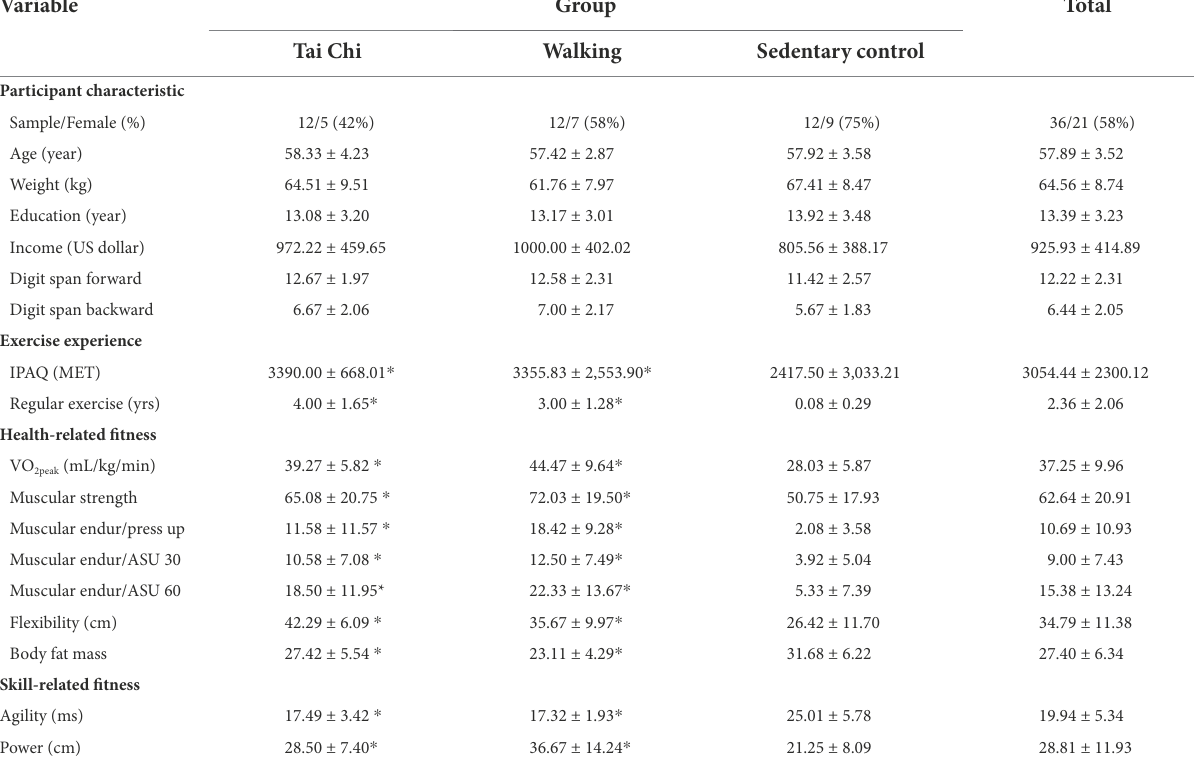
TABLE 1 Description of participants characteristic, exercise experience, and health-and skill-related fitness among three groups. Variable Group Tai